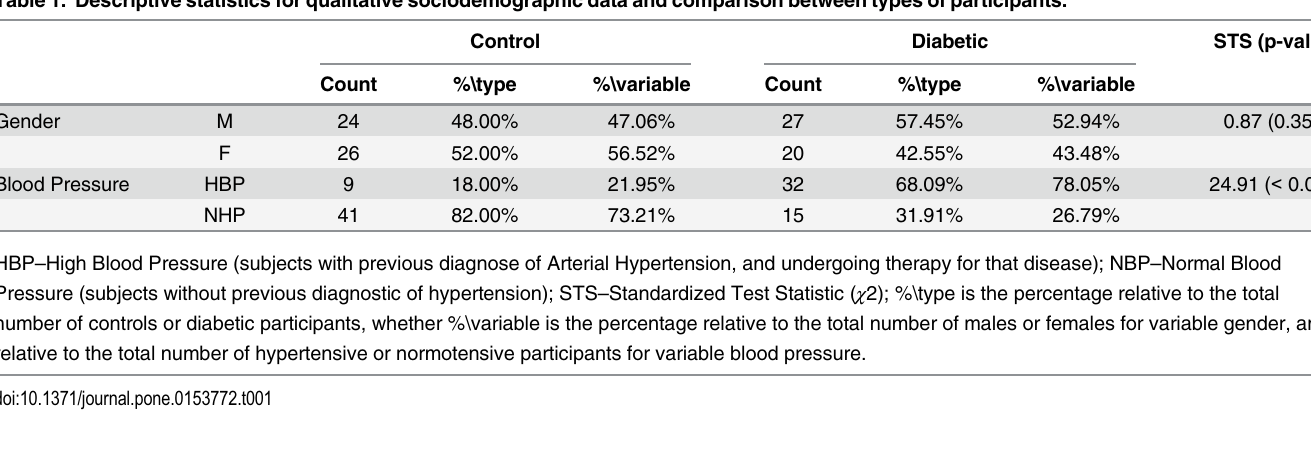
Table 1. Descriptive statistics for qualitative sociodemographic data and comparison between types of participants.